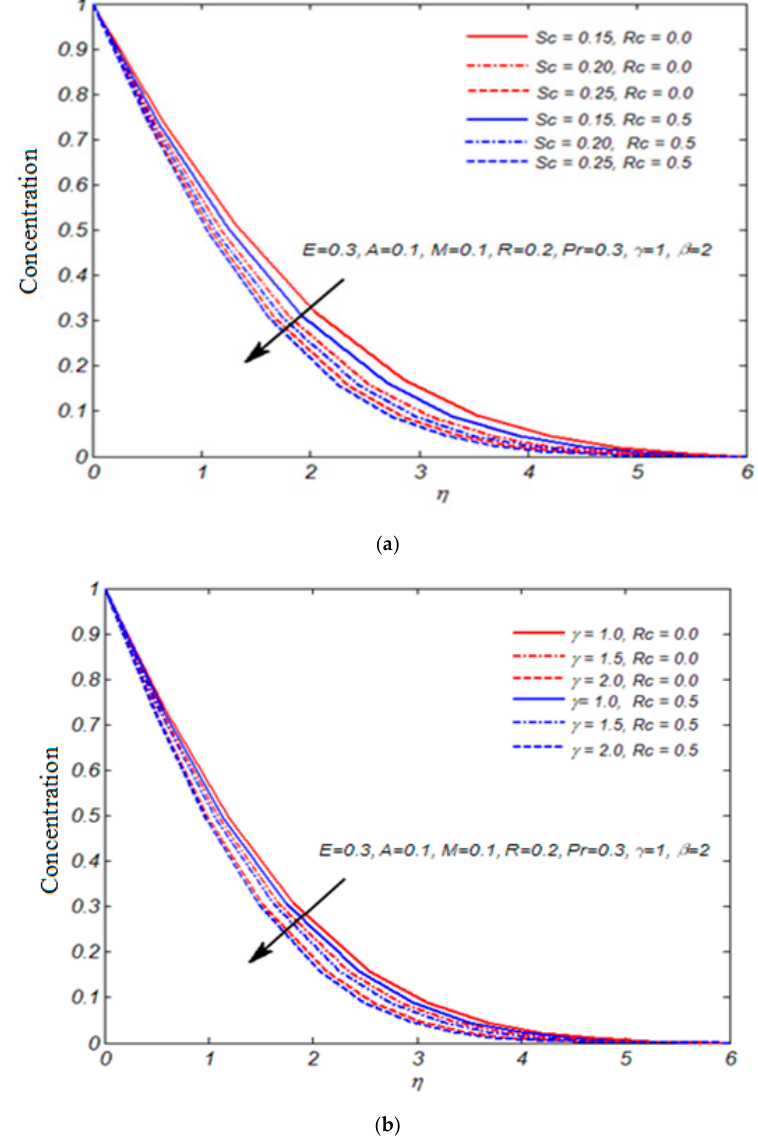
γ Figure 2. ( a ) Impact of Sc on ( ) φη . ( b ) Impact of on ( ) φη . Figure 2. ( a ) Impact of Sc on φ ( η ) . ( b ) Impact of γ on φ ( η ) Figure 1b displays the influence of the Casson fluid parameter on the velocity in sce- narios involving magnetic and non-magnetic fields. For higher Casson parameters, the velocity profile significantly increases. Both magnetic and non-magnetic fluid flows have